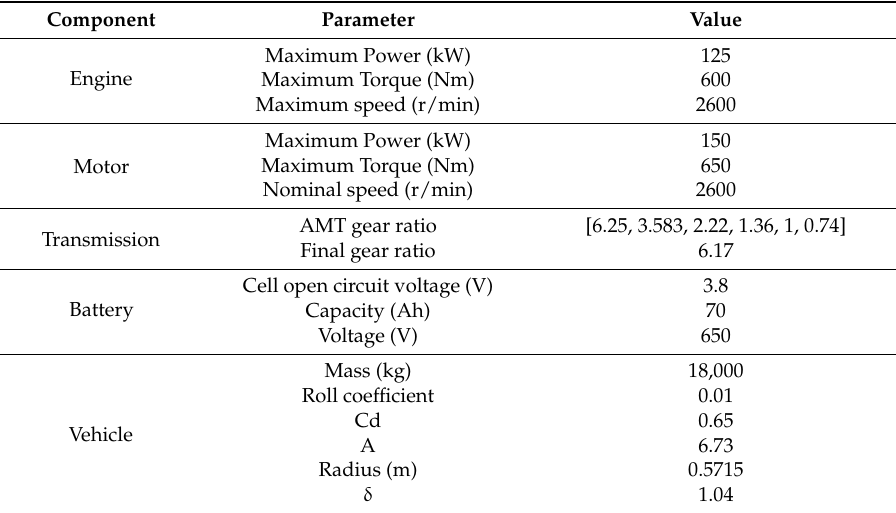
Table 3. The vehicle